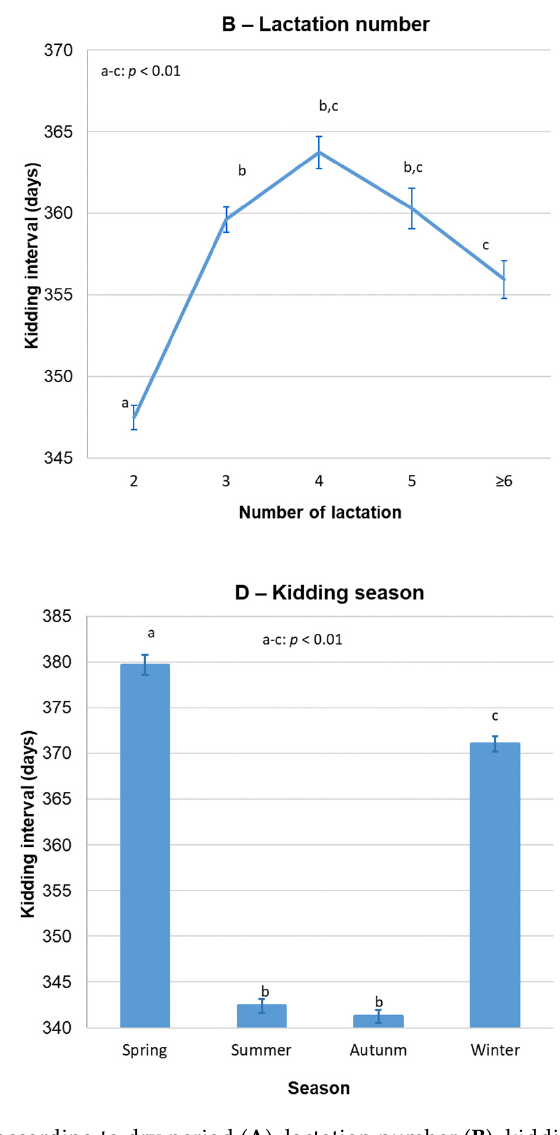
Table 2. Kidding interval (days ± SE) variation according to production system and kidding season for each dry period of Florida goats.